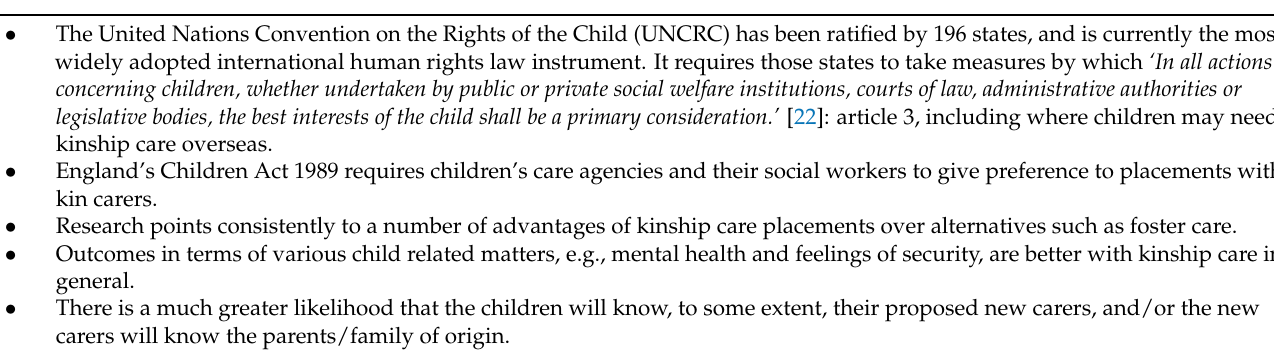
Table 1. Foundational framework for kinship